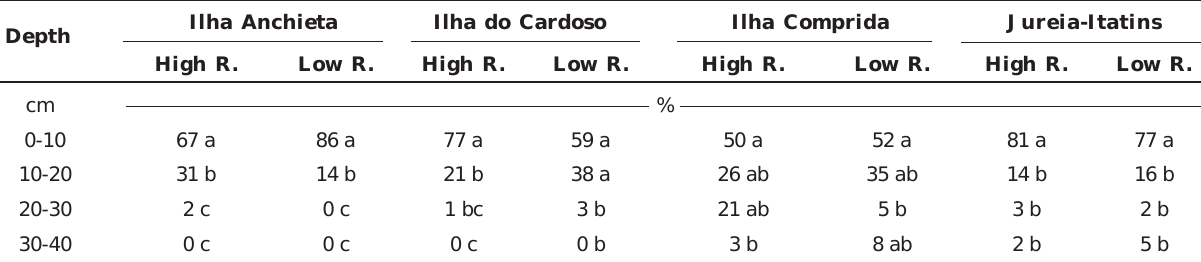
Table 4. Percentage of the root system distribution of restinga forest in the soil profiles at four study